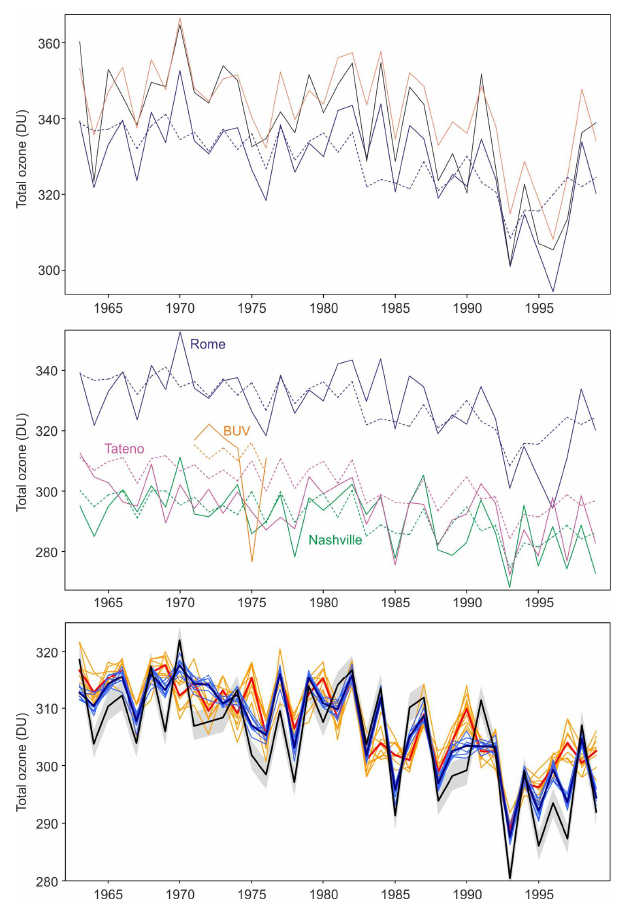
Figure 4. Example of the pre-processing steps of monthly mean total column ozone observation series performed in this paper. Top: Comparison of raw series (black), zonally adjusted series (orange), debiased series (blue solid), and ensemble mean background (debiased SOCOL, blue dashed) for the case of Rome. Middle: debiased observations (solid) and ensemble mean background (debiased SOCOL, dashed) for Rome, Tateno, Nashville, and BUV zonal mean data at 35-40°N. Bottom: Comparison of debiased observations (black, grey shading indicates the estimated observation error), background (ensemble mean and members, red and orange) and the final HISTOZ.1.0 product (ensemble mean and members, dark and light blue) for the average of the three stations Rome, Tateno, Nashville.